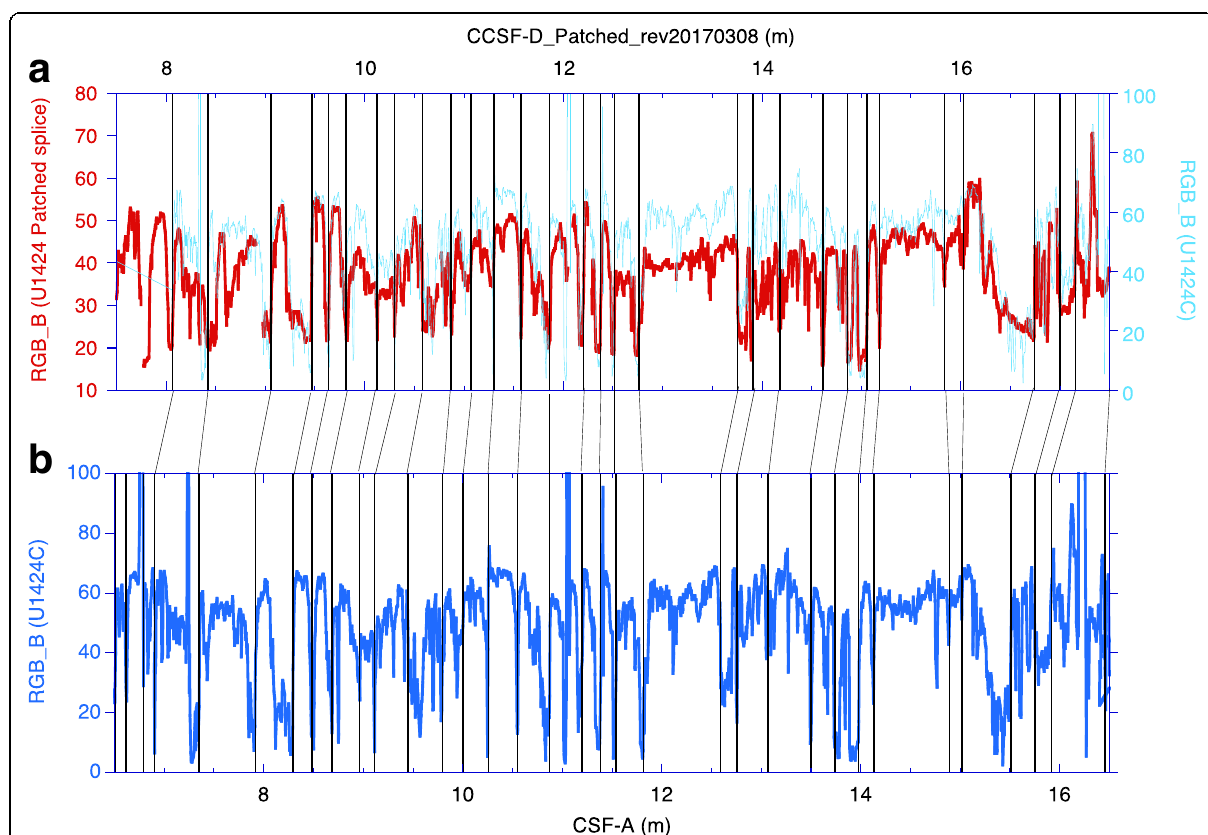
Fig. 6 Correlation of RGB_B profile between U1424 splice measured onboard ( a ) and Section U1424C-2H measured at Kochi Core Center (KCC) ( b ). RGB_B profile of KCC (blue line in b ) was correlated to RGB_B of the splice (red line in a ) at black vertical lines and was projected to splice depth scale (light blue line in a